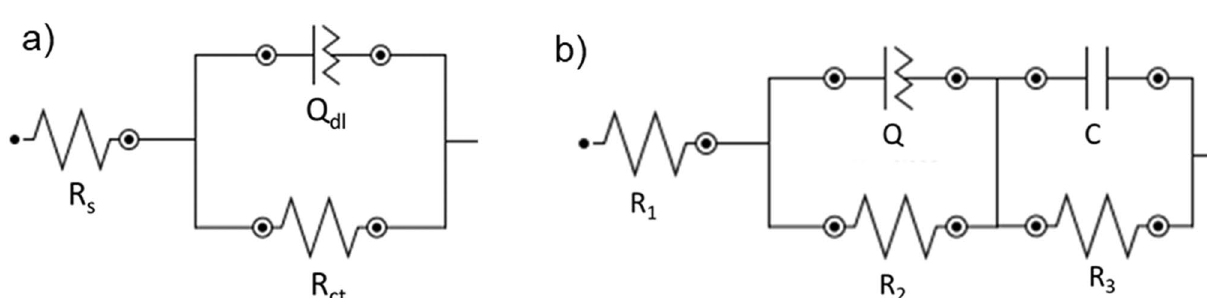
Figure 5. (a) The equivalent circuit used to model the EIS data for the BDD electrode and the BDD electrode decorated with 30 ± 14 nm AuNPs and (b) the equivalent circuit model for the pBDD electrode and the pBDD electrode decorated with 30 ± 11 nm